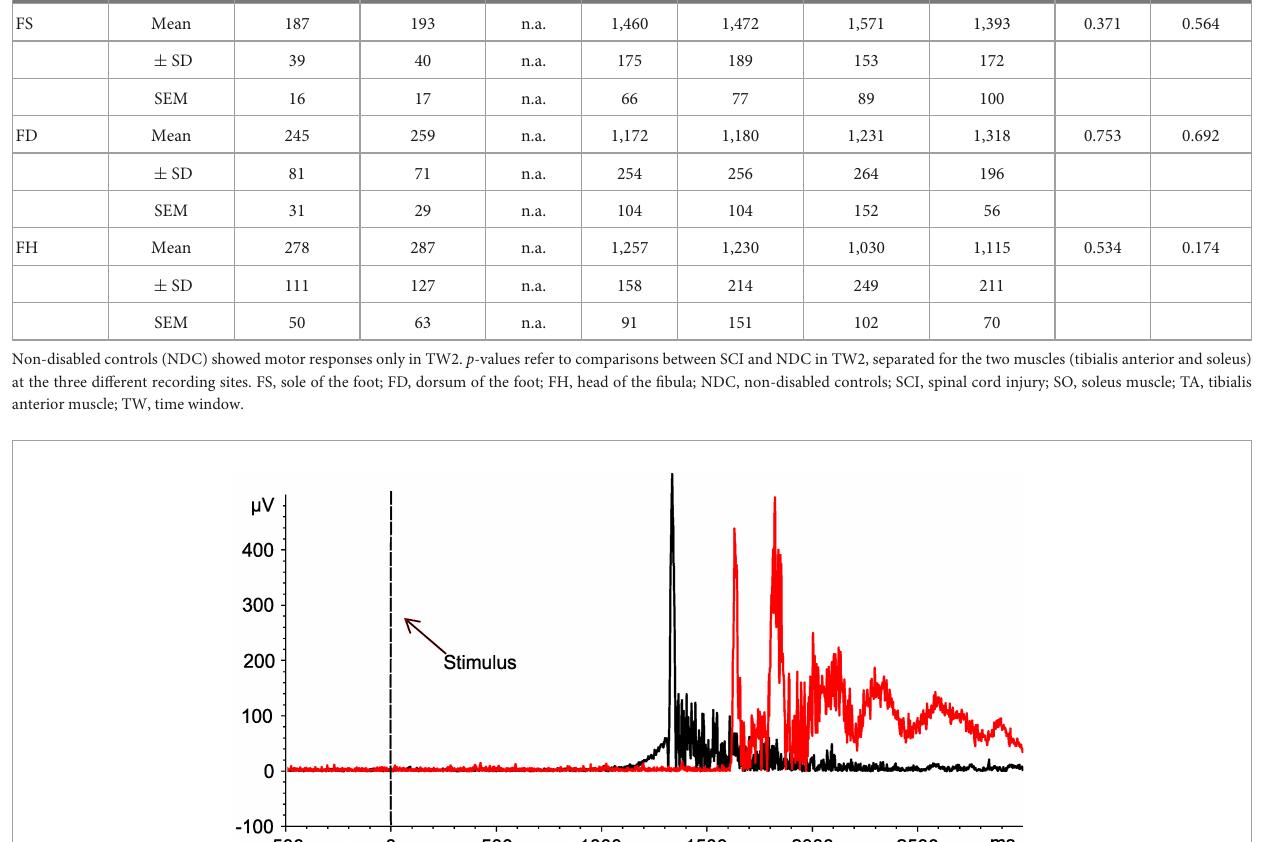
and the TW of their occurrence. Wilcoxon rank-sum test was used to evaluate differences by group comparison (NDC versus